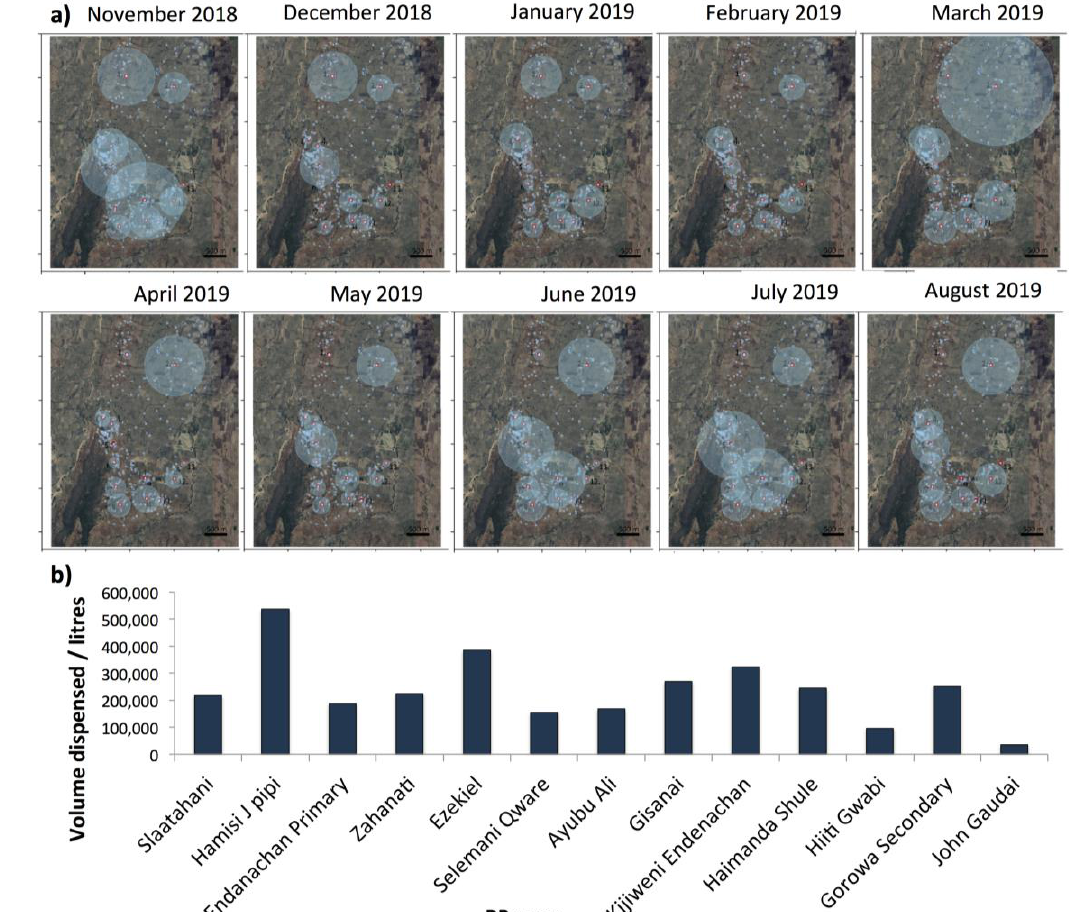
Figure 4. ( a ) Frames of a moving image showing volume (radius of blue disc) dispensed from each DP in Community A (November 2018–August 2019), mapped for each location. Blue dots represent all households. Each frame represents one month. These can be watched for November 2018–August 2019 for Community A and Community B for the same time period at: https://streamable.com/2h1jt; streamable.com/z4jvl; ( b ) Total volume dispensed for each named DP over the same time period.